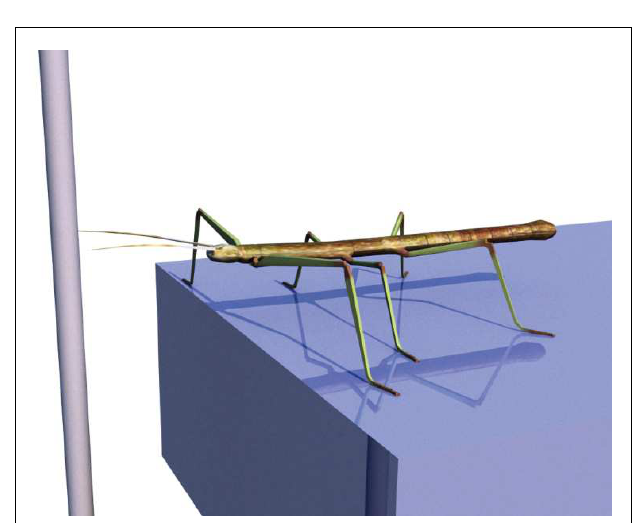
FIGURE 4 |Vectors constituting the thorax model (view from above). In (A) the vectors describing the foot point with respect to the segments are shown. (B) Shows how these vectors are changed when the model is pulled